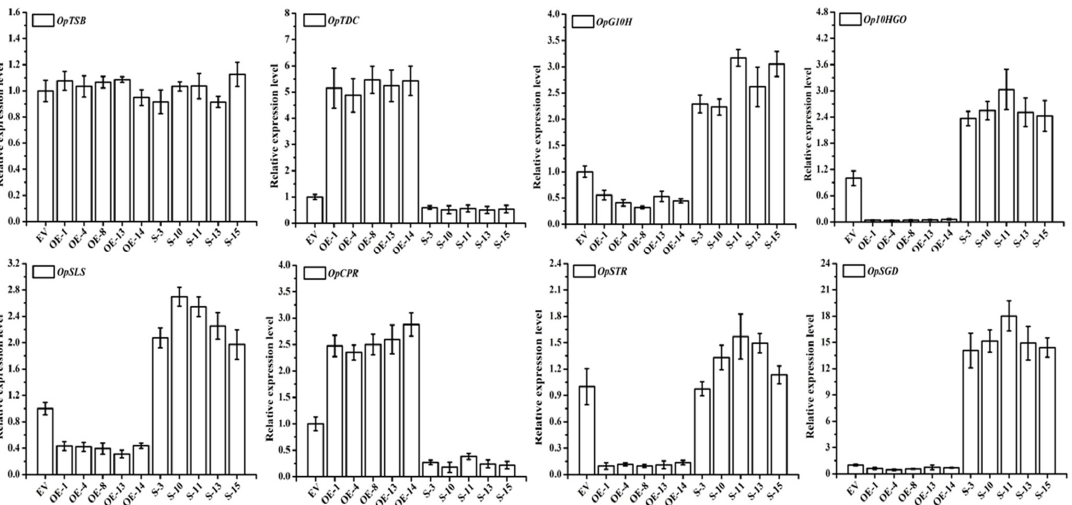
Figure 5. The total production of CPT and its precursors in OpWRKY3 transgenic hairy roots. ( A ) The total production of tryptamine in OpWRKY3 transgenic hairy roots and medium by high performance liquid chromatography (HPLC); ( B ) The total production of loganin in OpWRKY3 transgenic hairy roots and medium by HPLC; ( C ) The total production of secologanin in OpWRKY3 transgenic hairy roots by HPLC; ( D ) The total production of CPT in OpWRKY3 transgenic hairy roots and medium by HPLC. Values are means ± standard deviation of triplicate analyses. ∗ , significant at P < 0.05, ∗∗ , highly significant at P < 0.01.